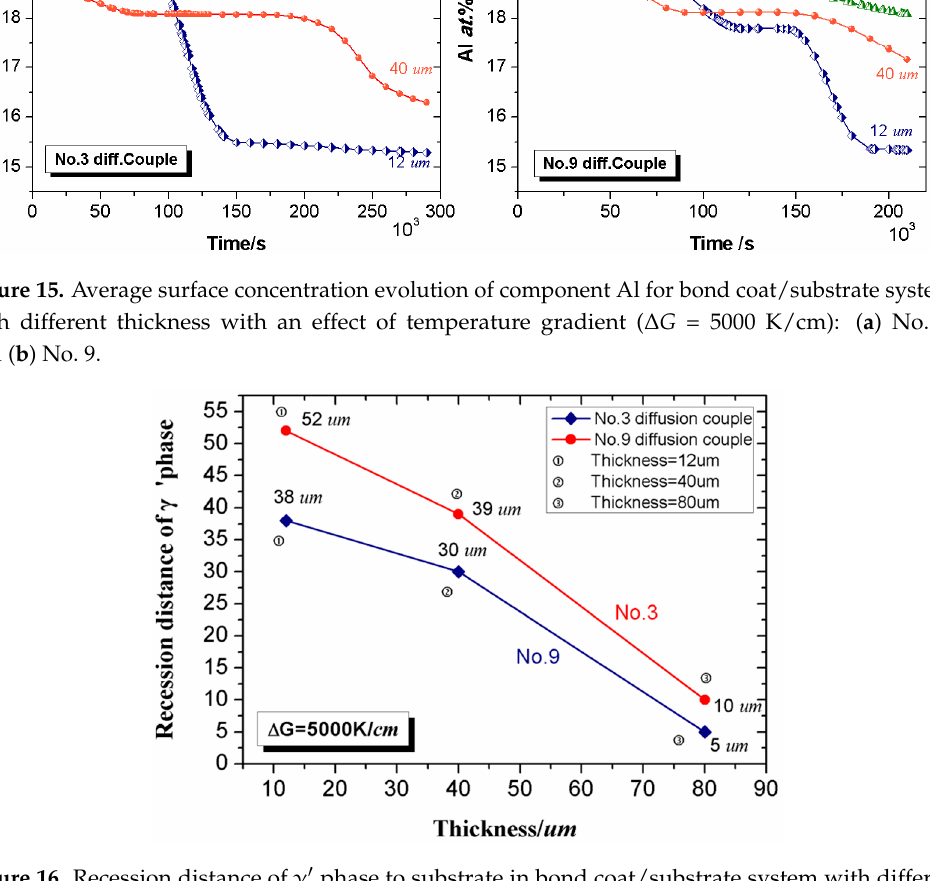
Figure 16. Recession distance of γ ' phase to substrate in bond coat/substrate system with different thickness with an effect of temperature gradient ( Δ G = 5000 K/cm).